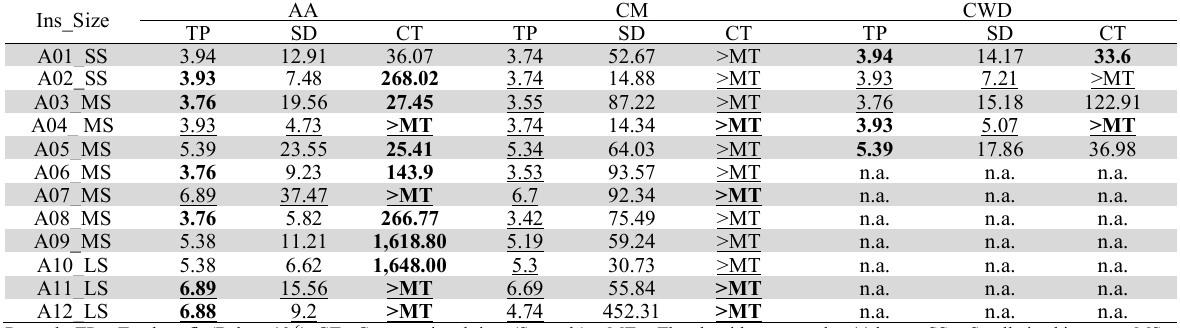
Comparison of the computational results of the AA method and the CM and CWD methods AA CM CWD Ins_Size TP SD